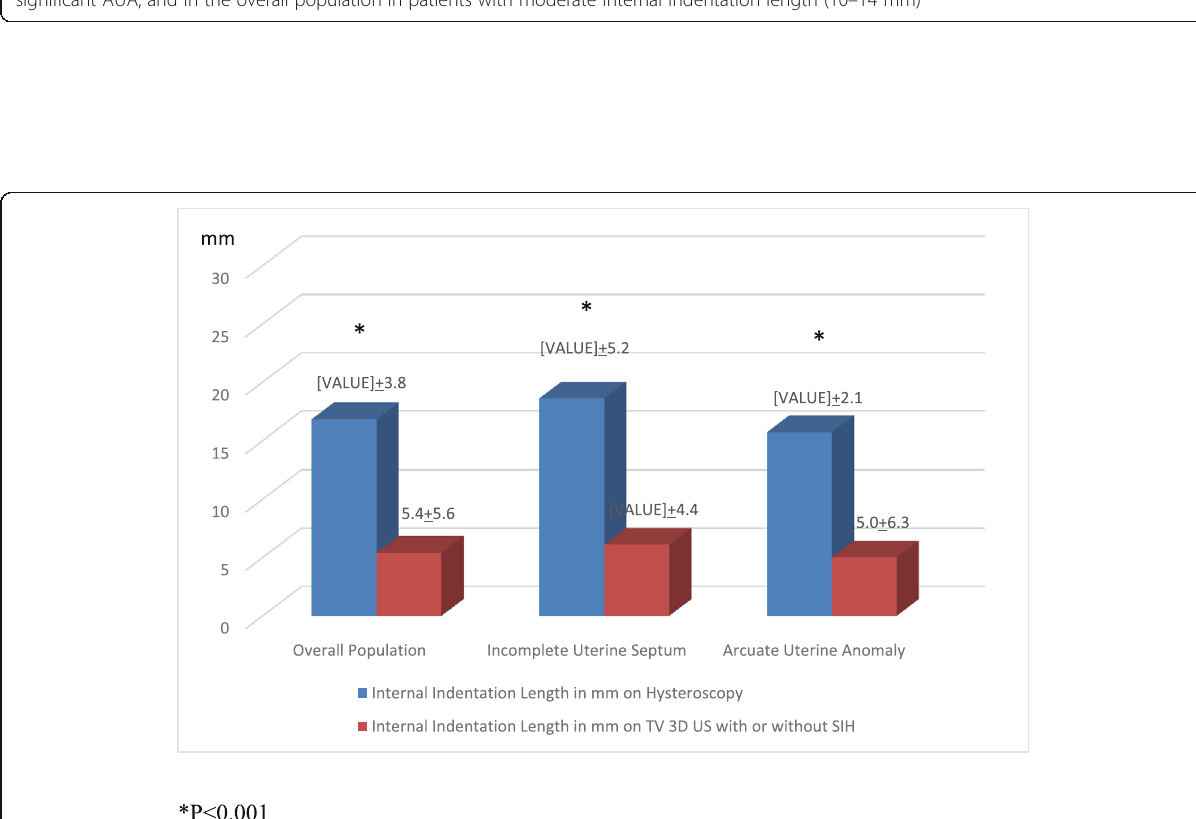
Fig. 5 Comparison between the mean IILFM measured in mm on hysteroscopy and on TV 3D US with or without SIH, in patients with IUS, significant AUA, and in the overall population in patients with moderate internal indentation length (10 – 14 mm)